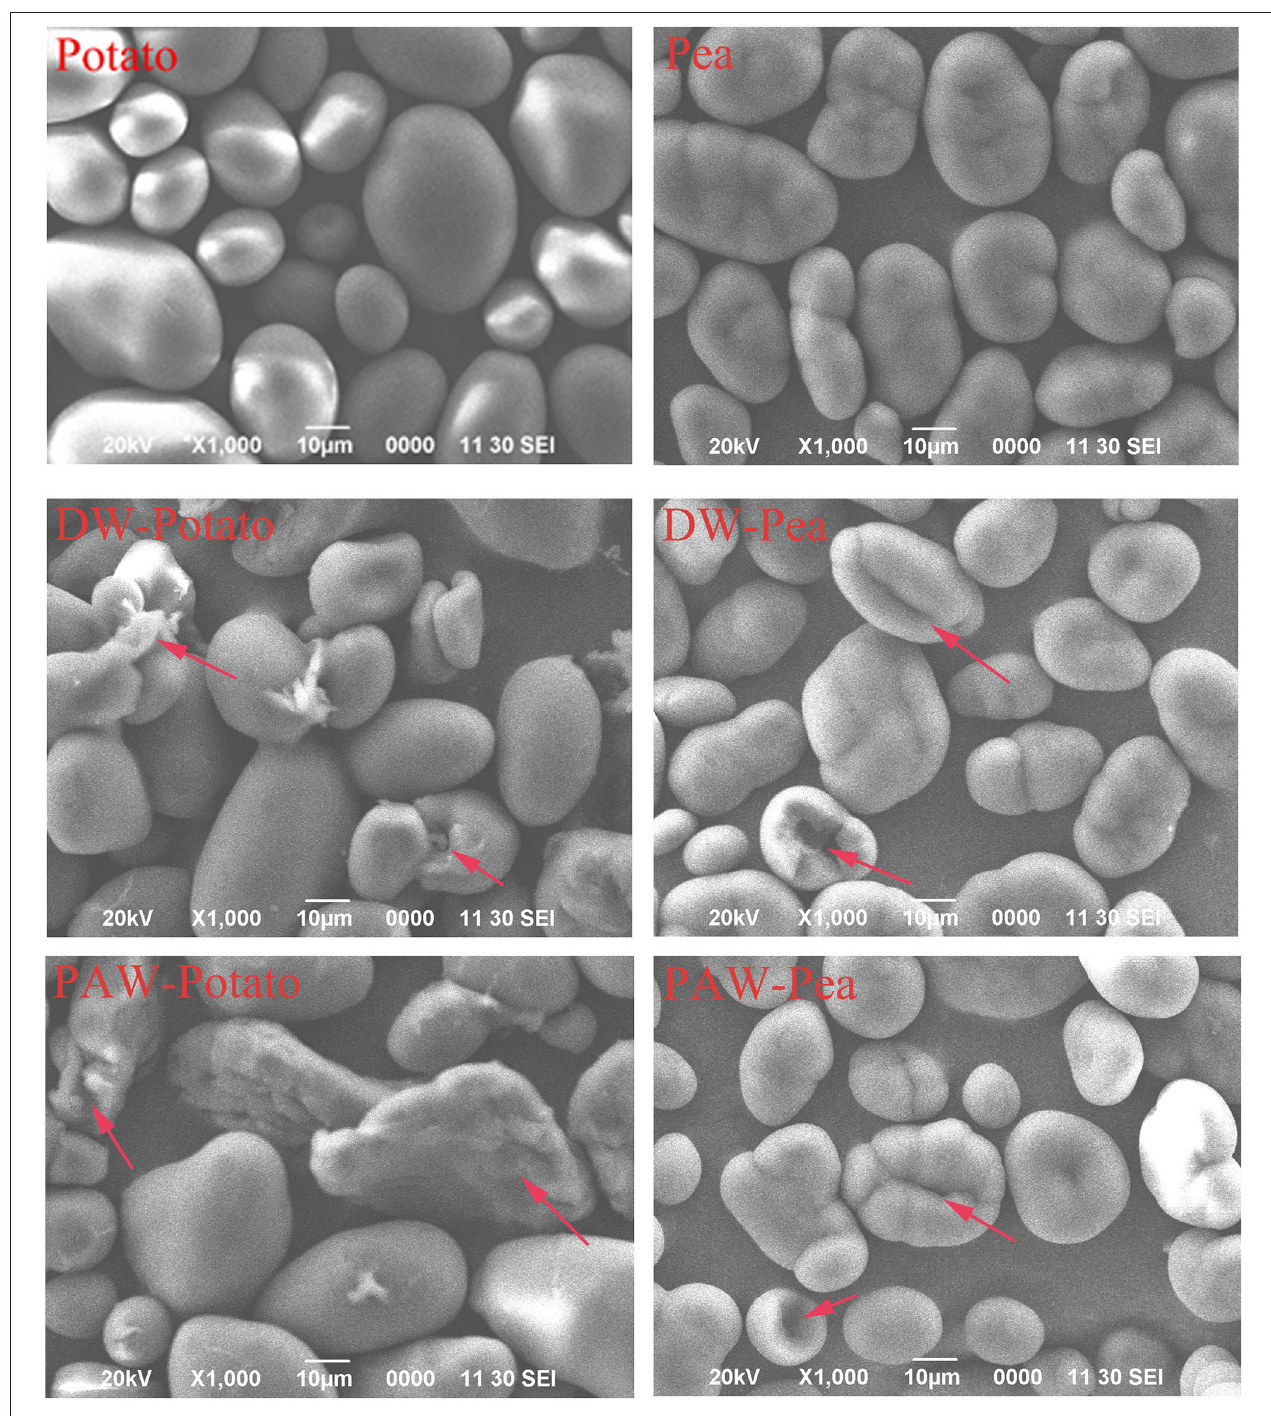
FIGURE 1 | Scanning electron microscopy (SEM) images of native and modified starches.